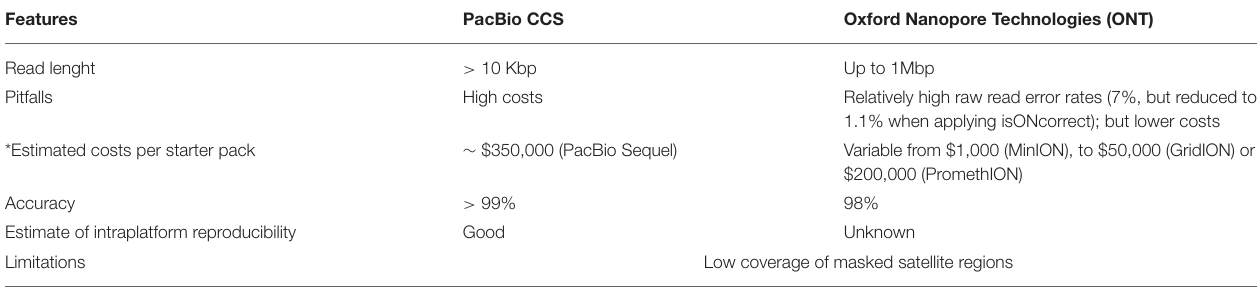
TABLE 3 | Main features of the two long-read sequencing platforms: PacBio CCS and ONT. Features